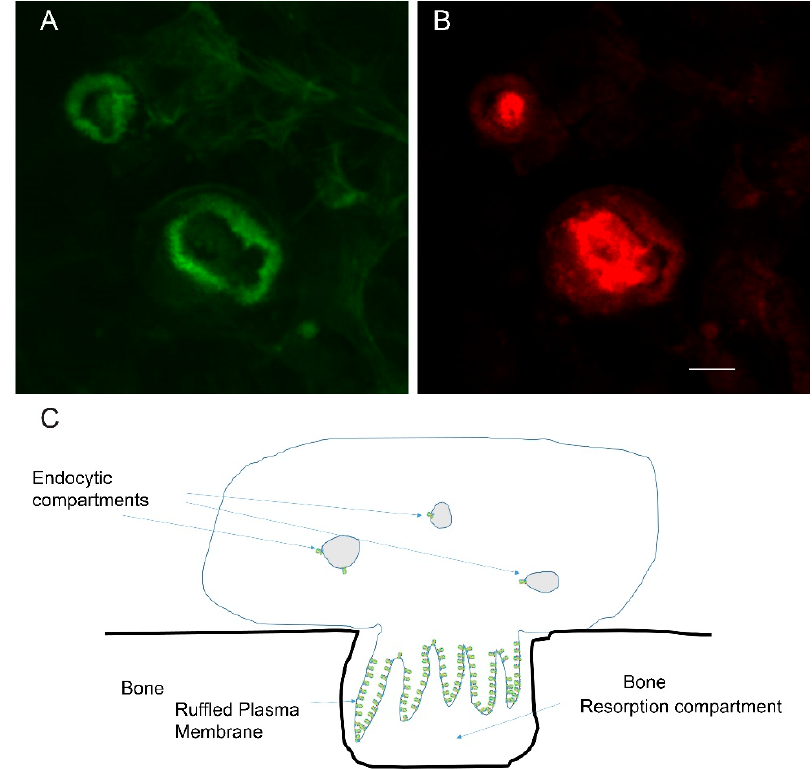
Figure 1. Osteoclasts are specialized cells that can resorb mineralized matrix. To do this they form a resorption compartment that depends on generation of an actin ring and ruffled plasma membrane; ( A ) Confocal micrograph of resorbing osteoclasts on a bone slice stained with phalloidin, which detects filamentous actin, and pseudocolored green. Two actin rings are shown in the field of view; ( B ) The same cells as in ‘A’ are stained (pseudocolored red) with an antibody that binds the E ‐ subunit of the V-ATPase, a component of the ruffled plasma membrane. The vacuolar H + -ATPase (V-ATPase) is responsible for pumping protons to acidify an extracellular resorption compartment. The scale bar for ‘A’ and ‘B’ is 5 µ m; ( C ) Schematic of a resorbing osteoclast. The ruffled membrane is packed with many V-ATPases (indicated in green). In contrast, endocytic compartments in osteoclasts and other cells require only a few V-ATPases to acidify the compartment. The actin ring, depicted in cross section, is based on actin filaments undergoing rapid polymerization at the cytosolic face of the plasma membrane, and depolymerization toward the center of the cell. The plasma membrane abutted by the actin ring conforms tightly with the bone, creating the extracellular resorption compartment.